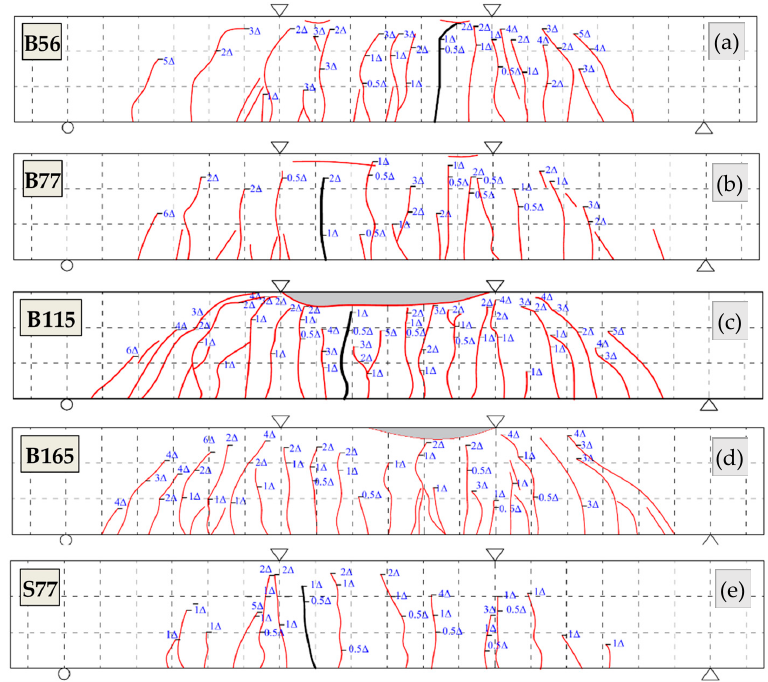
Figure 7. Crack patterns: ( a ) B56; ( b ) B77; ( c ) B115; ( d ) B165; ( e ) S77.